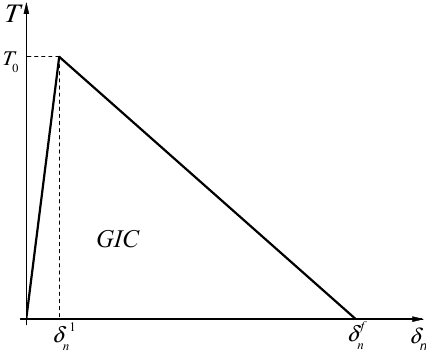
Figure 2. Relationship between cohesive force and crack separation for model I fracture.